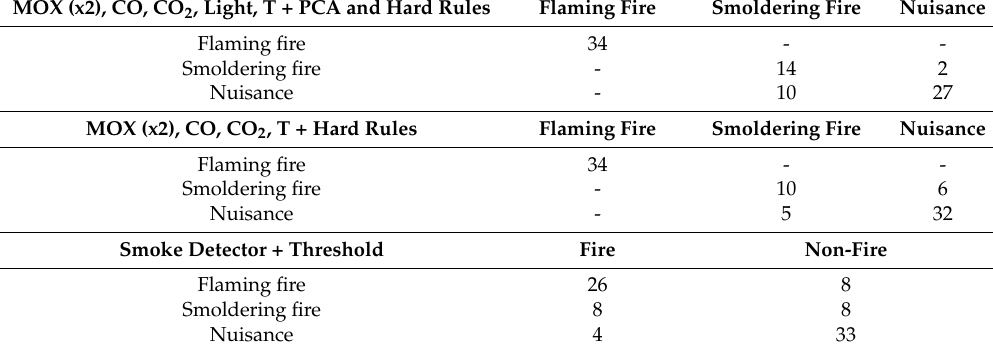
Table 6. Confusion matrices for the multisensor system with 2 MOX, CO, CO 2 , T and light obscuration sensors with dimensionality reduction and hard rules (top, from [63]); the multisensory system with 2 MOX, CO, CO 2 and T with hard rules (middle, from [62]); the commercial smoke detector (bottom, from